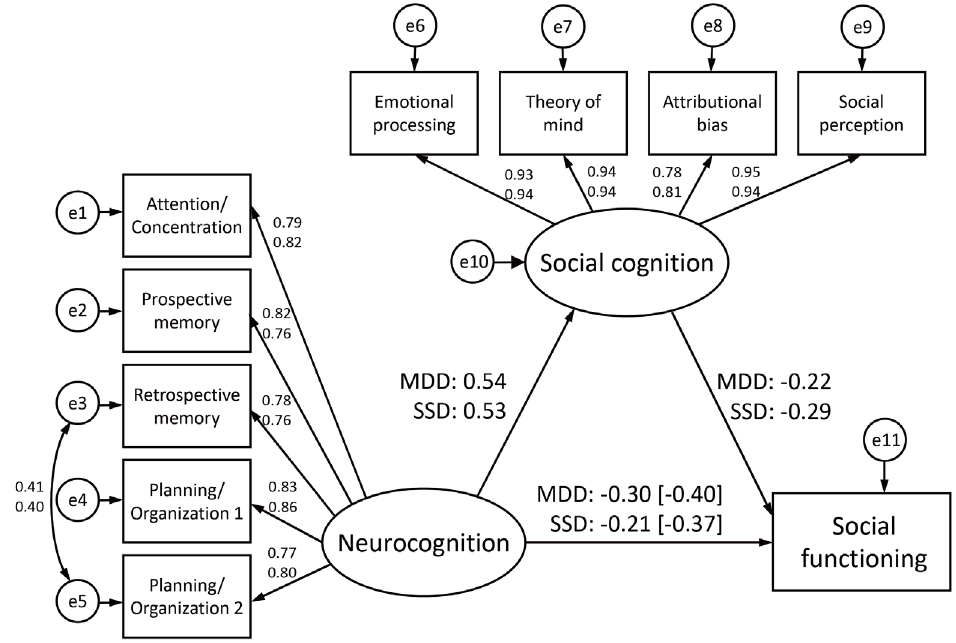
Figure 1. Mediation effects of social cognition on the relationship between neurocognition and social functioning in patients with schizophrenia spectrum disorders or major depressive disorder. The numbers in square brackets are standardized coefficients of the direct effect of neurocognition on social functioning. The numbers in the upper row are the standardized coefficients for the major depressive disorder group, while those in the lower row are the standardized coefficients for the schizophrenia spectrum disorders group.